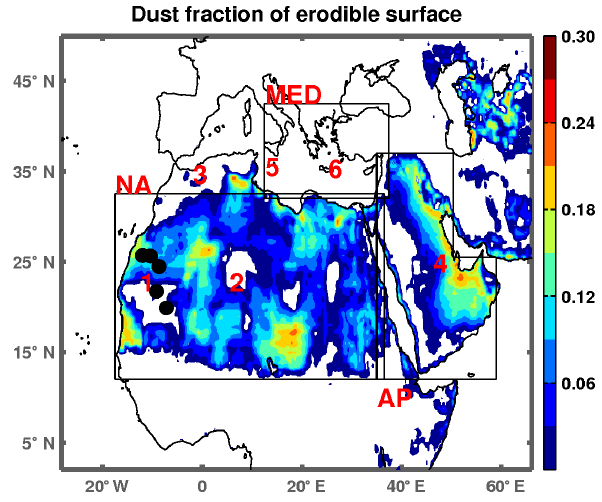
Figure 1. Fraction of erodible surface after Ginoux et al. (2001). Boxes depict the three sub-regions of North Africa (NA), Arabian Peninsula (AP) and the eastern Mediterranean (MED). Numbers represent the locations of AERONET stations used in this study and black bullets show the locations of airplane retrievals of the vertical profiles of extinction coefficients. The AERONET stations are (1) Zouerate, (2) Tamanrasset, (3) Oujda, (4) Solar Village, (5) Lampedusa and (6)